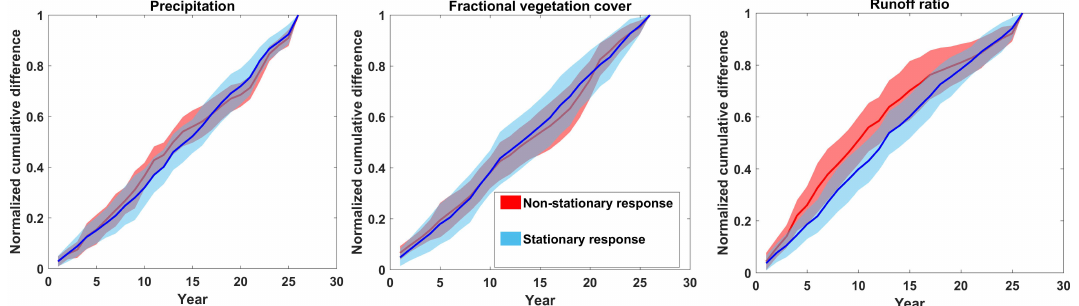
Figure 3. Mean normalized cumulative absolute differences in annual precipitation, fractional vegetation cover and runoff ratio between catchments with non-stationary (20 catchments) and stationary (146 catchments) hydrologic response. The shaded areas represent standard deviations.